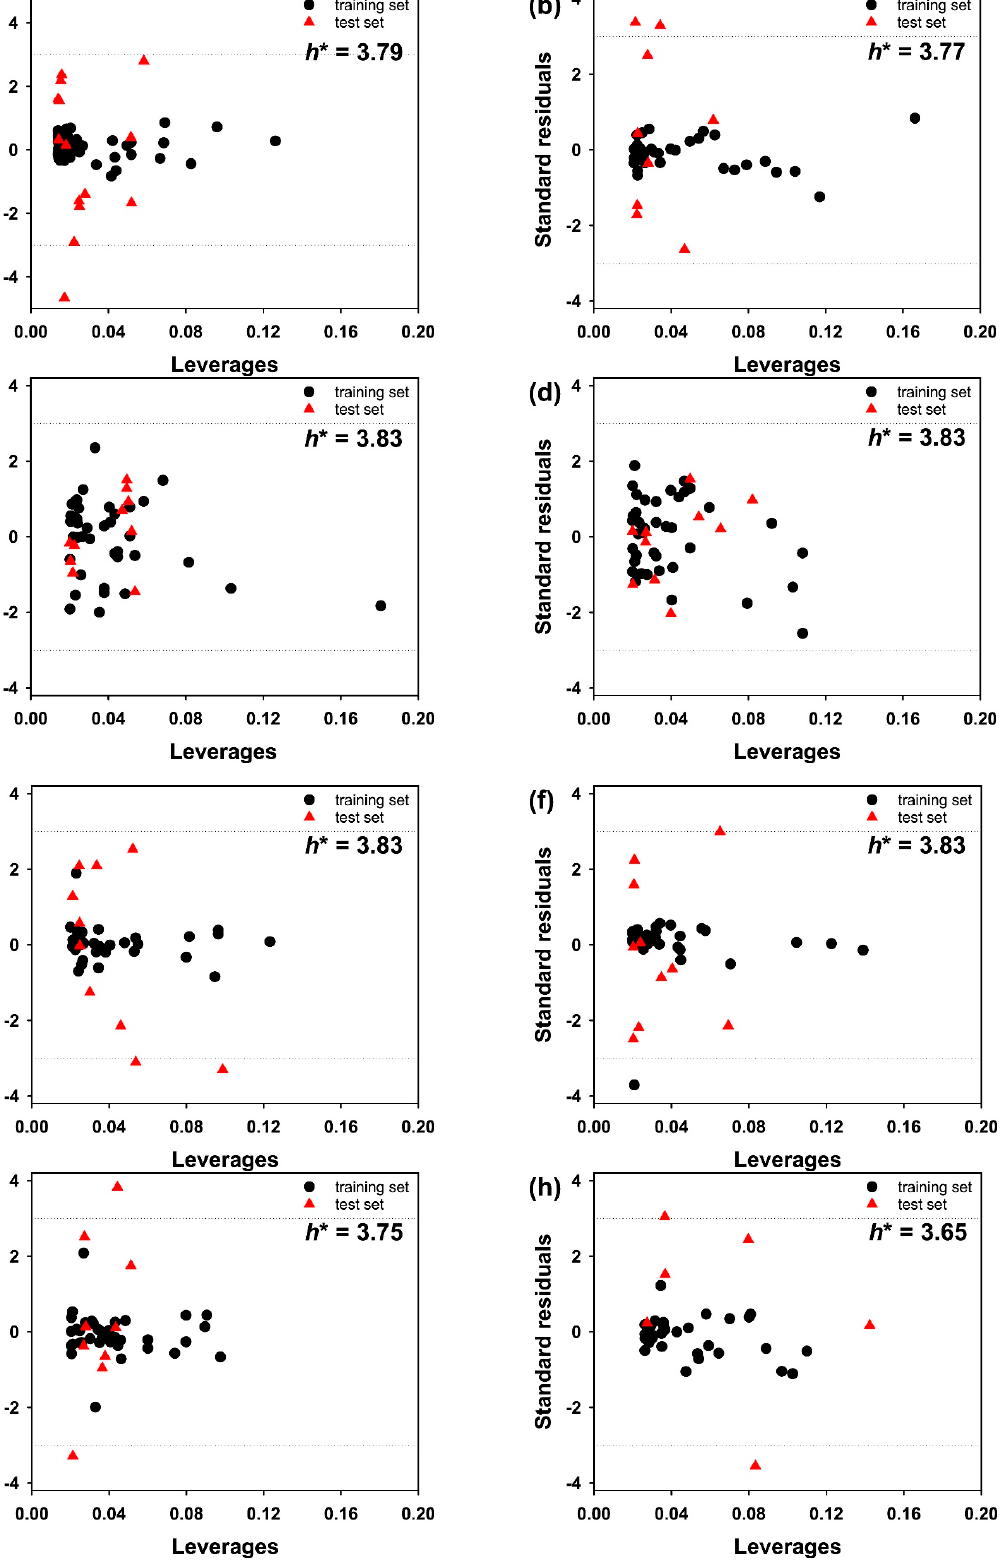
Figure 6. William plots of the LogBB predictions for ( a ) Subset 1, ( b ) Subset 2, ( c ) Subset 3, ( d ) Subset 4, ( e ) Subset 5, ( f ) Subset 6, ( g ) Subset 7, and ( h ) Subset 8. Indicated in black circles and red triangles are the molecules in the training and test sets, respectively. The dashed lines indicate the boundaries of the applicability realm. Warning leverage values ( h*’s ) are indicated in numbers instead of vertical lines because they reside too far from the data points.